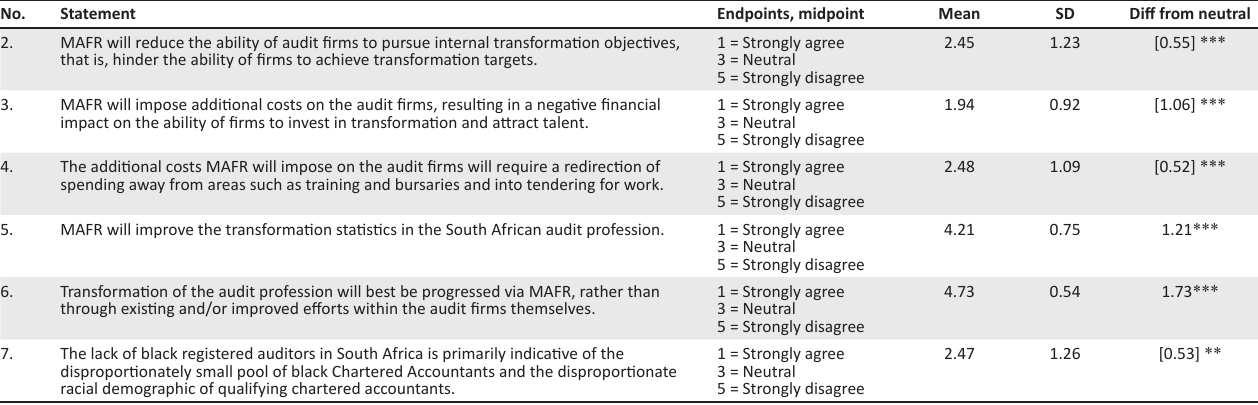
TABLE 2: Big 4 audit partners’ perspectives on